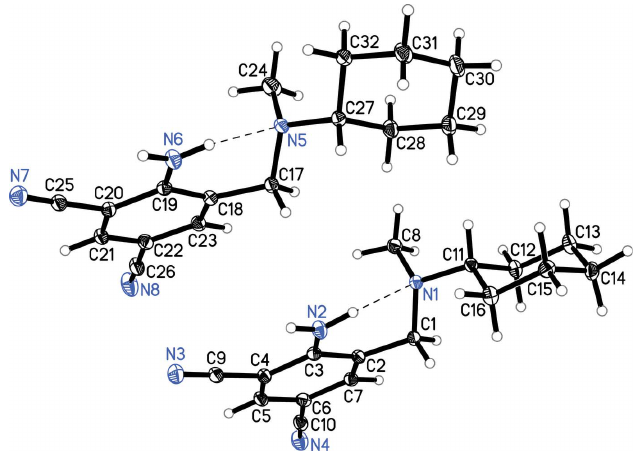
Figure 1 The asymmetric unit of the title compound, with intramolecular hydrogen bonds drawn as dashed lines. Displacement ellipsoids are shown at the 30% probability level.